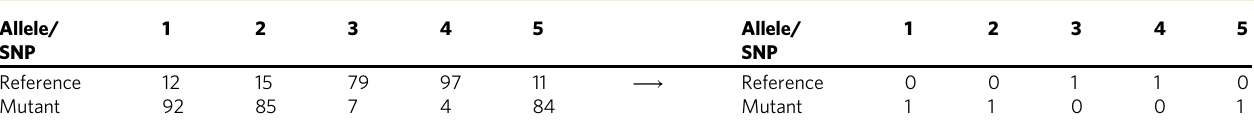
Table 4 A toy phasing example on fi ve SNPs: the counts of mutant/reference allele observations for each SNP (left) and the inferred haplotypes (right), assuming that the differential haplotype expression was β = 0.9. Allele/